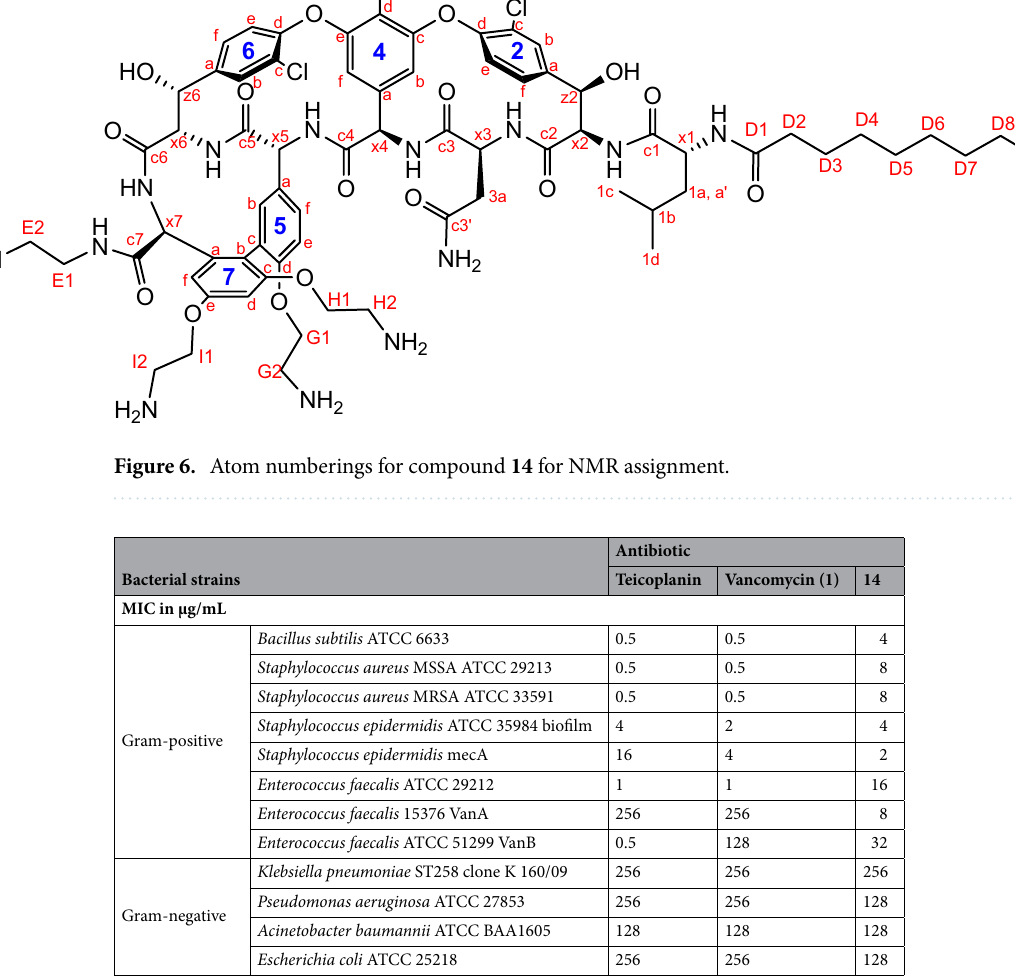
Table 3. Antibacterial activity. ATCC American type culture collection, MSSA methicillin-sensitive Staphylococcus aureus , MRSA methicillin-resistant Staphylococcus aureus , mecA mecA gene expression in Staphylococcus , VanA vanA gene positive, VanB vanB gene positive, MIC minimum inhibitory concentration.